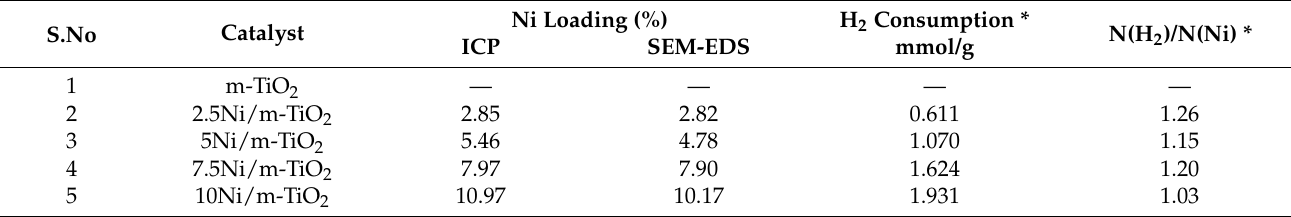
Table 1. Ni loading and properties of xNi/m-TiO 2